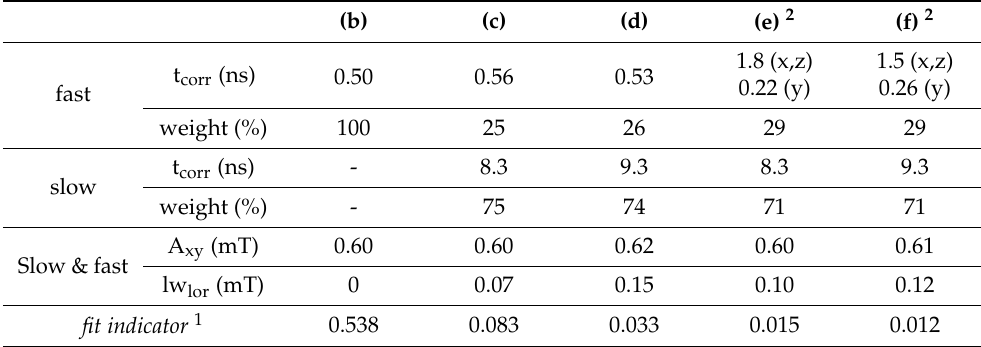
Table 2. Variable parameters used to obtain the simulations shown in magenta Figure 6b–f for sample 2. The fast component and the slow component refer to the blue and green traces shown Figure 6, respectively. The other fixed parameters are: Az = 3.54 mT, g x = f(A z ) = 2.0087, g y = 2.0061 and g z = 2.0022 at 9.45